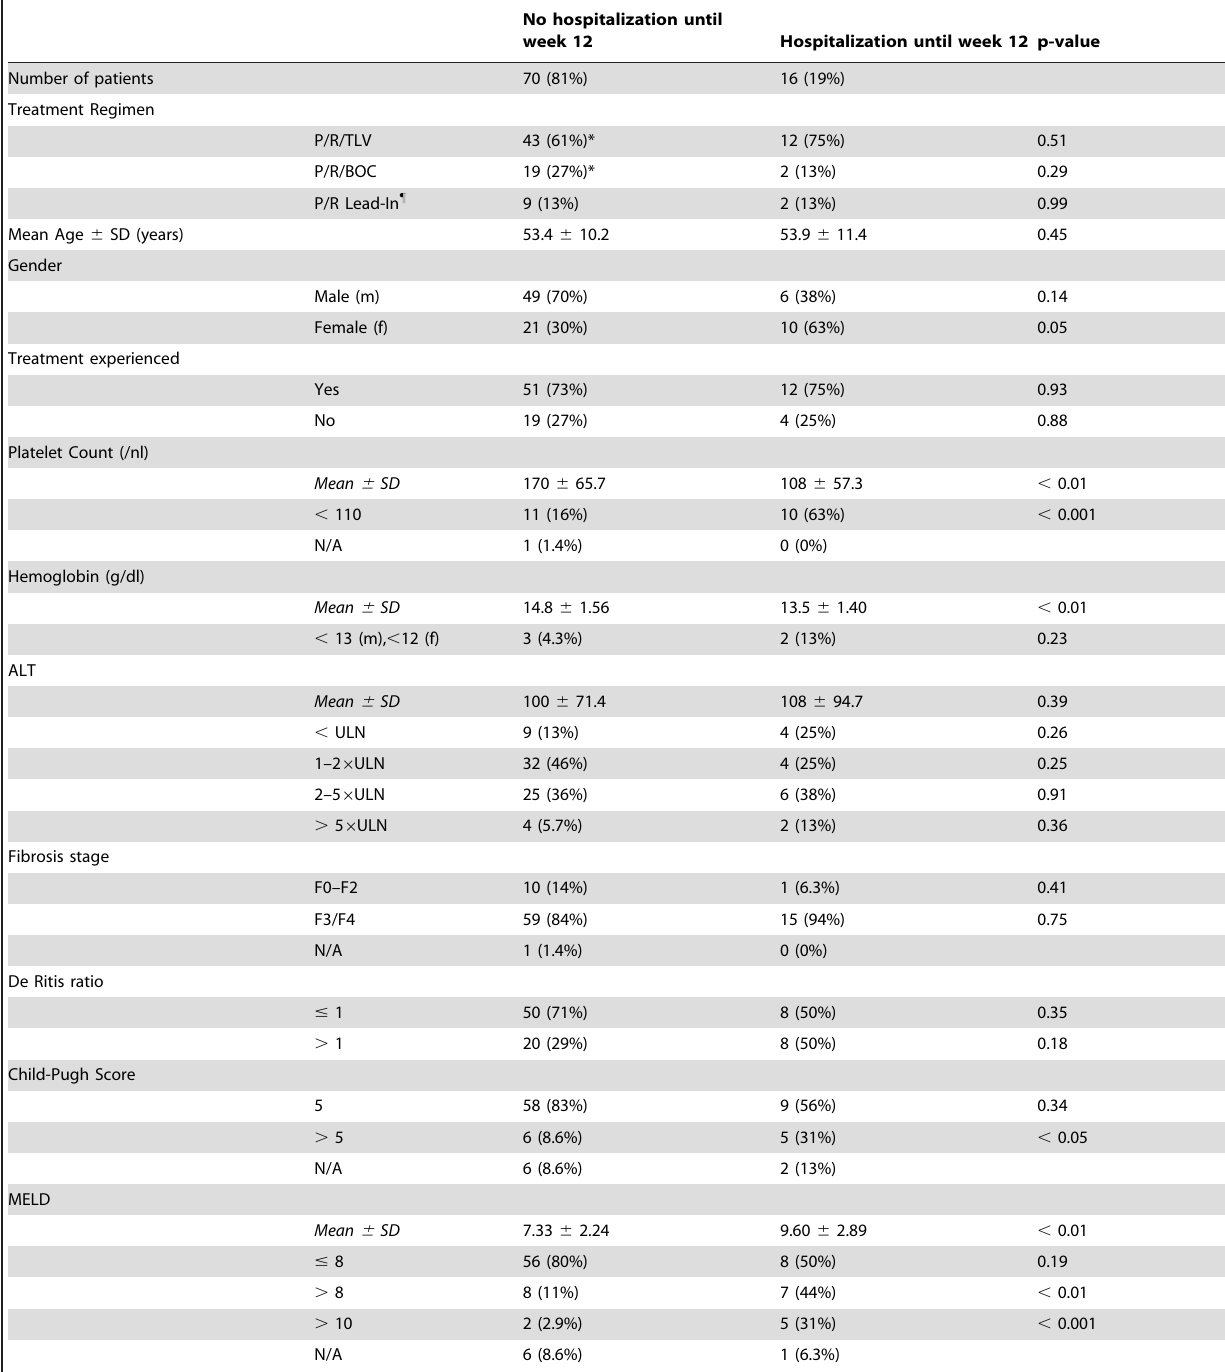
Table 3. Baseline characteristics of patients who were hospitalized until week